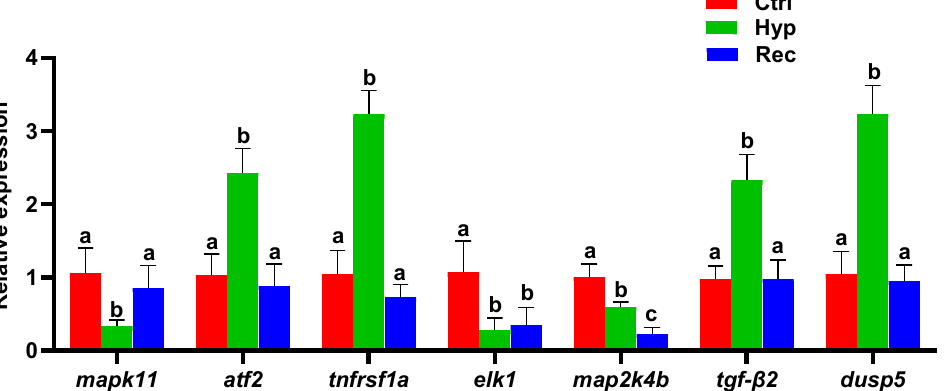
Figure 7. qRT-PCR analysis of differentially expressed genes in Ctrl group, Hyp group, and Rec group ( n = 12). Different letters indicate significant differences in gene transcript levels among groups.